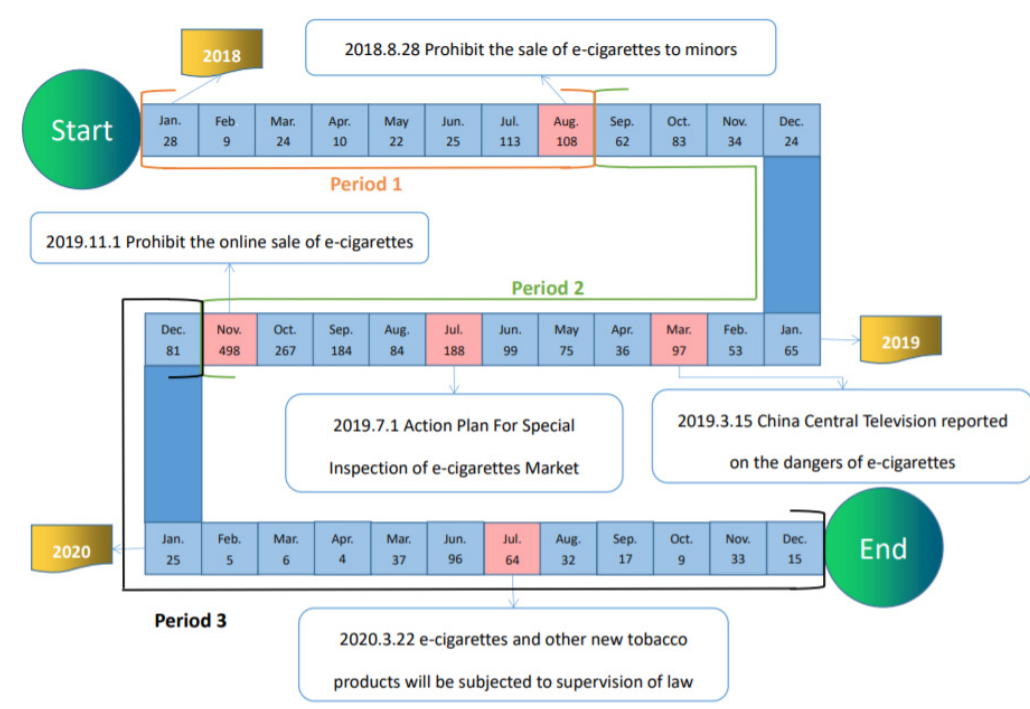
Figure 6. Timeseries of News Streams with Corresponding Policies during 2018–2020.